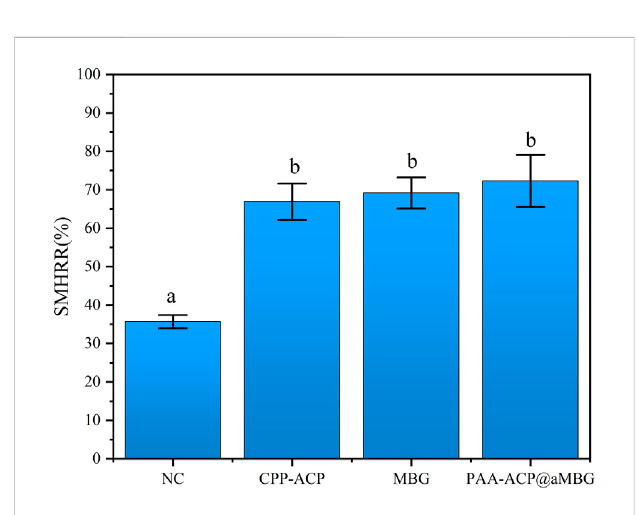
FIGURE 4 The surface microhardness recovery rates (SMHRR values) of the four groups. Identical letters indicate non-signi fi cant differences ( p >